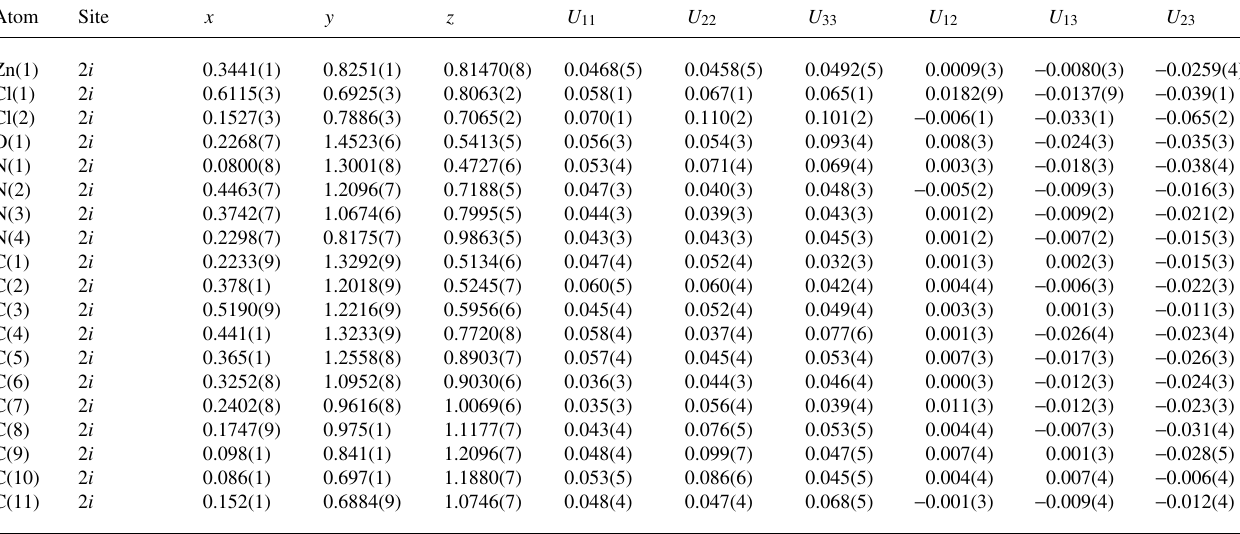
Table 3. Atomic coordinates and displacement parameters (in Å 2 )